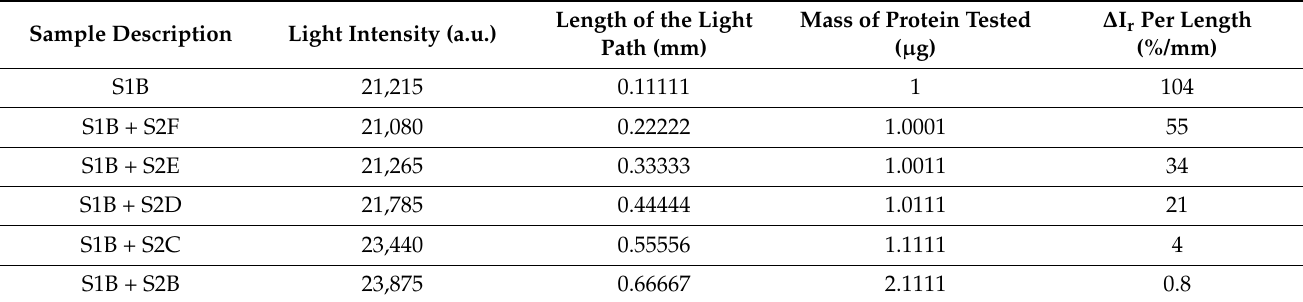
Table 1. List of measured and extracted